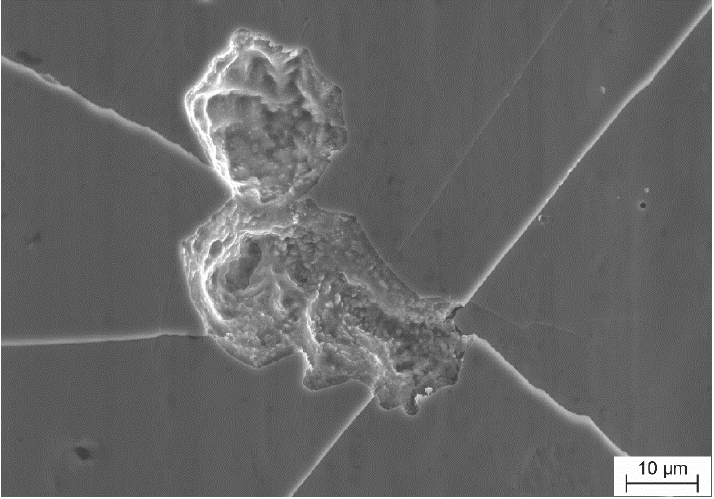
Figure 3. SEM image of a pit on the lateral surface of a bulk glassy Zr 59 Ti 3 Cu 20 Al 10 Ni 8 alloy sample compressed to